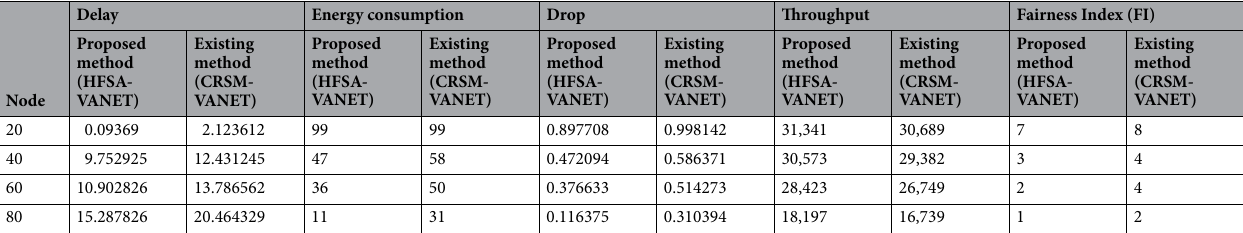
Table 1. Comparison with existing approach.